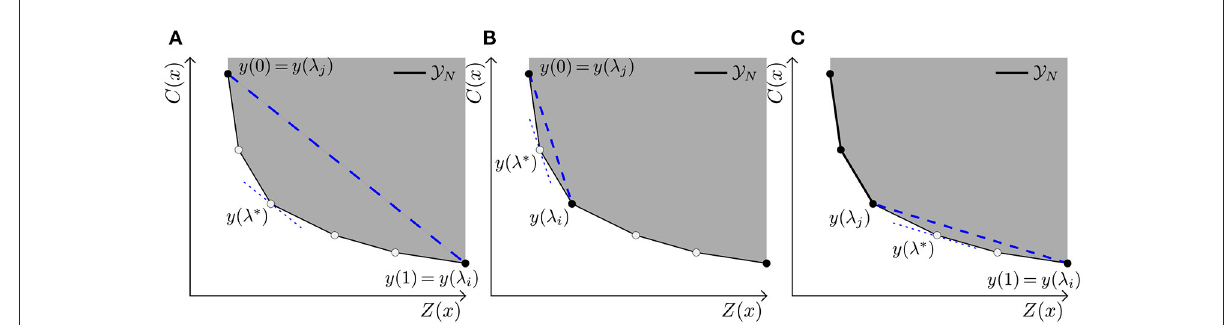
FIGURE2 Representation of NISE with linear inequalities. As explained in Algorithm 1, the slope of already found efficient points is used to determine new efficient points. Here, when we refer to a “Line” we refer to a specific Line in Algorithm 1. (A) Based on the start solutions found in Line 3, a λ related to their slope is determined in Line 7. With λ = λ ∗ a new efficient point is found in Line 8. (B) Based on the found point, the area is split in ( y ( λ i ), y ( λ ∗ ) ) and y ( λ ∗ ), y ( λ j ) , hence Line 13, and for both sides the same procedure can be repeated. That is, a new λ is determined resulting in a new efficient point. (C) Procedure is repeated until no new points are added to the existing Y N (cid:0) (cid:1)